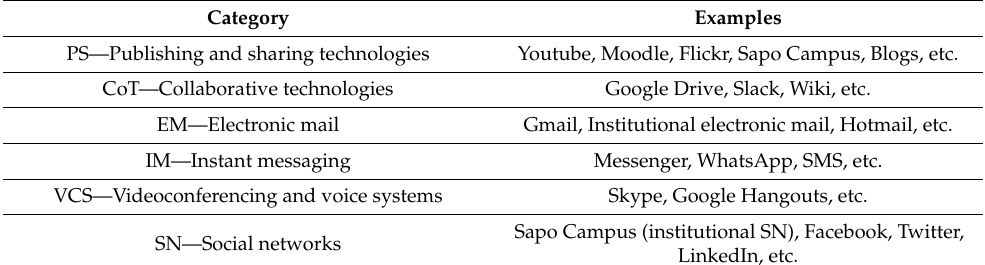
Table 2. Taxonomy of communication